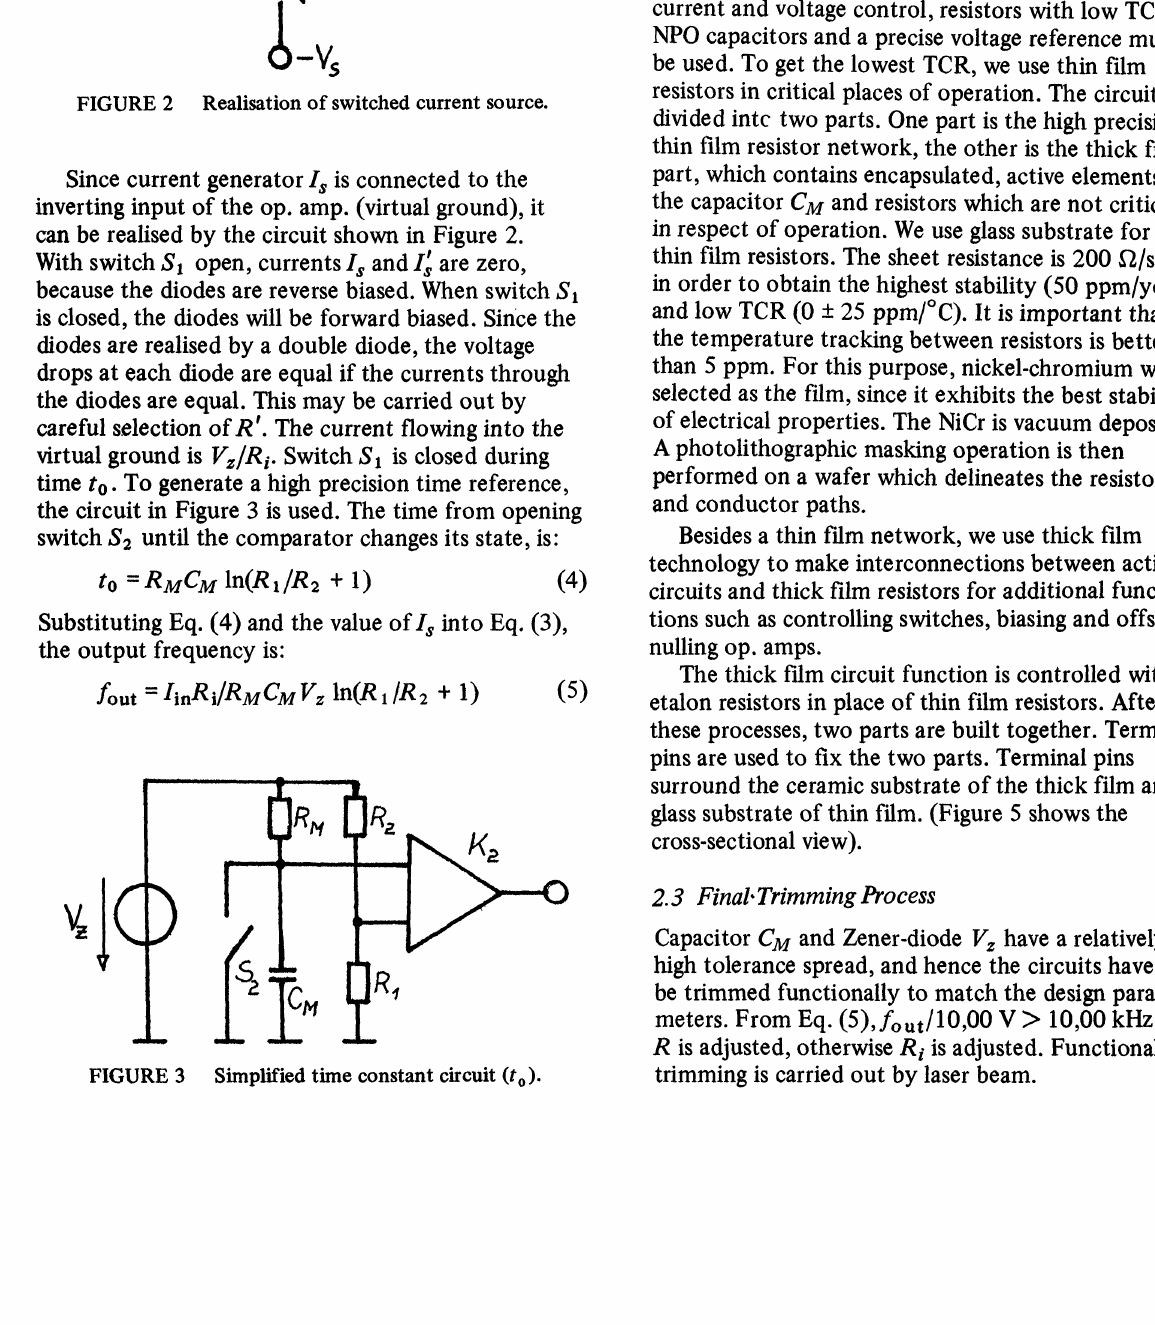
FIGURE 3 Simplified time constant circuit